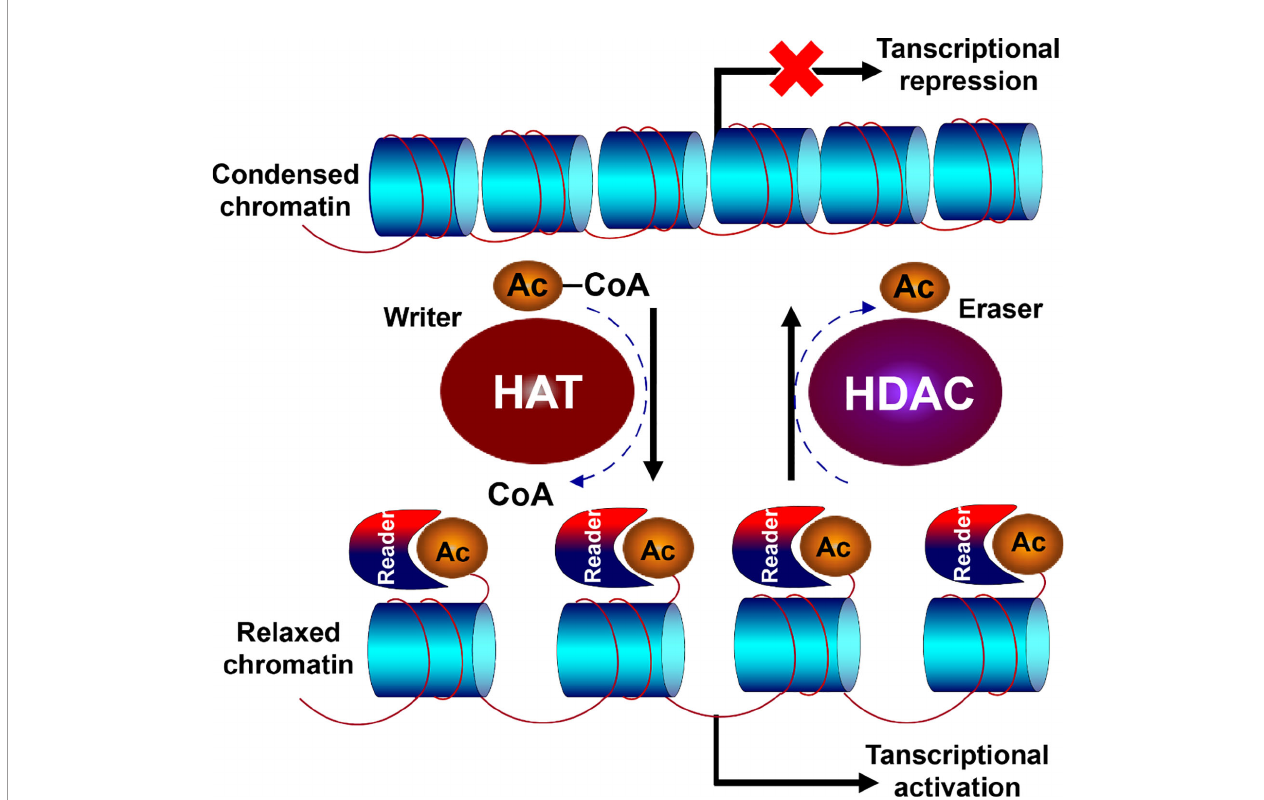
FIGURE 2 | Opposite function of HDACs and HATs. HDAC and HAT play opposite roles in the epigenetic modi fi cation of chromatin. HAT transfers the acetyl group from acetyl coenzyme A to lysine residual of histone N-terminal with positive charge, which binds to DNA strand with negative charge and prevents the chromatin from being condensed, allowing the chromatin relaxed for gene transcription. Oppositely, HDACs remove the acetyl group from histone tail, and subsequently condenses the chromatin, resulting in transcriptional